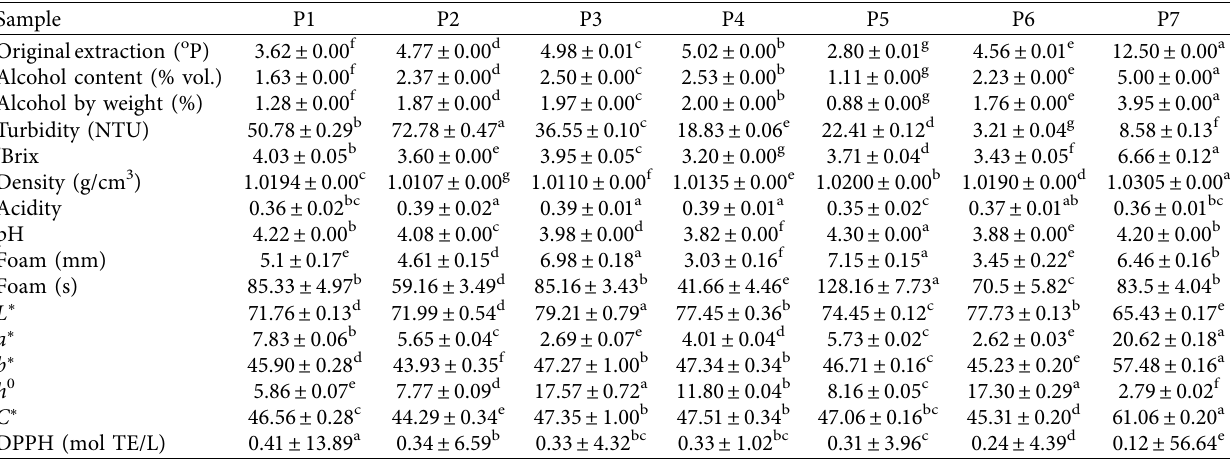
Table 1: Physiochemical properties of